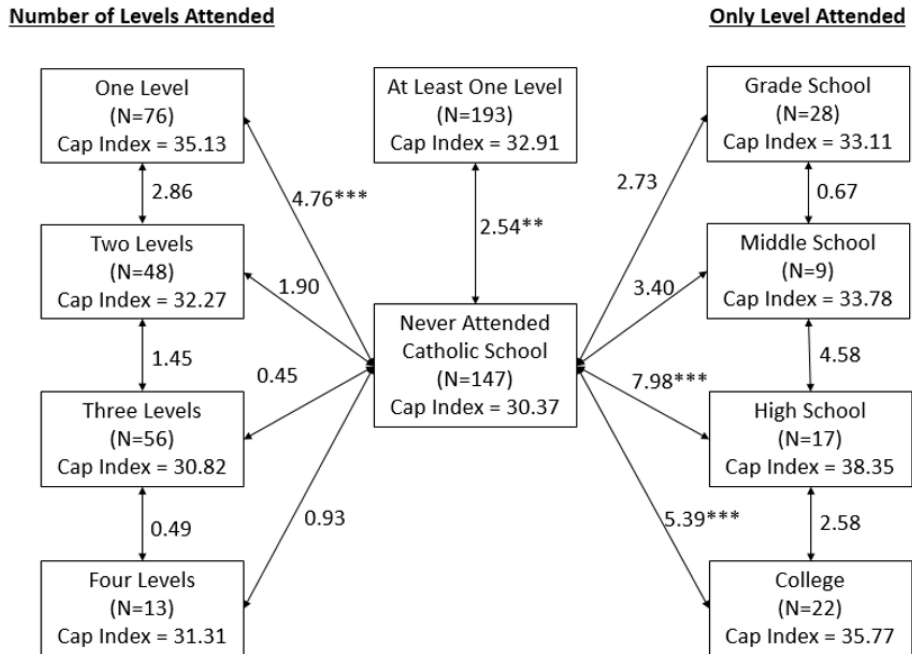
Figure 2. Remainers’ Capitalism index by Catholic school attendance. The number next to connecting arrows represents the difference in subgroups’ capitalism index scores, and asterisks indicate the level of statistical significance from a t -test. ** p < 0.05, and *** p < 0.01.